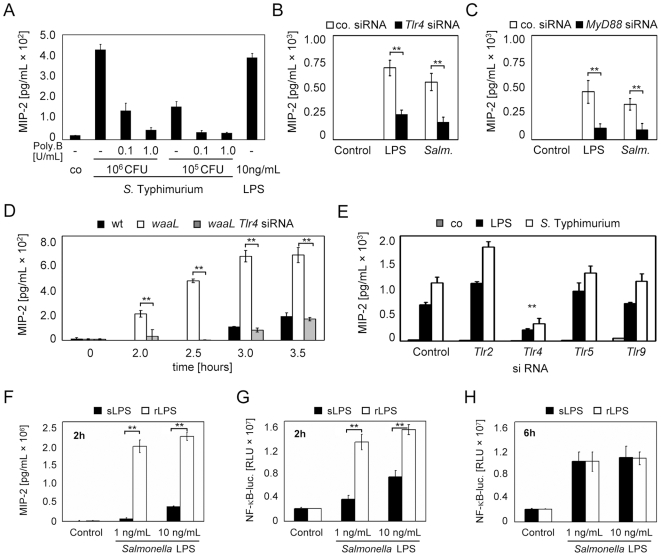
LPS recognition is critical for early epithelial activation by Salmonella.(A) Wildtype S. Typhimurium were coincubated with confluent m-ICcl2 cells at a MOI of 10∶1 (106/mL) or 1∶1 (105/mL) for 1 h and the cell culture supernatant was removed, sterile filtered, and used to stimulate naive m-ICcl2 cells in the absence, or presence of the indicated concentrations of polymyxin B for 6 h. Rough LPS (D31m4) was included as control. (B and C) MIP-2 secretion by m-ICcl2 cells treated with control-, and (B) Tlr4-specific, or (C) MyD88-specific siRNA 6 h after exposure to rough LPS (10 ng/mL) or wildtype S. Typhimurium at a MOI of 10∶1. (D) MIP-2 secretion by m-ICcl2 cells exposed to wildtype Salmonella, or an isogenic waaL-mutant for the indicated time after treatment with control, or Tlr4-specific siRNA. (E) MIP-2 secretion by m-ICcl2 cells treated with control, Tlr2-, Tlr4-, Tlr5, or Tlr9-specific siRNA 6 h after exposure to rough LPS, or wildtype S. Typhimurium. (F–H) m-ICcl2 cells (F), or stably transfected m-ICcl2 cells expressing a NF-κB-luciferase construct (G and H), were exposed to Salmonella smooth LPS (sLPS), or Salmonella rough LPS (rLPS) at the indicated concentrations for 2 hours (F and G), or 6 hours (H) and the secreted MIP-2, or luciferase, respectively, was quantified. **, p<0.01.